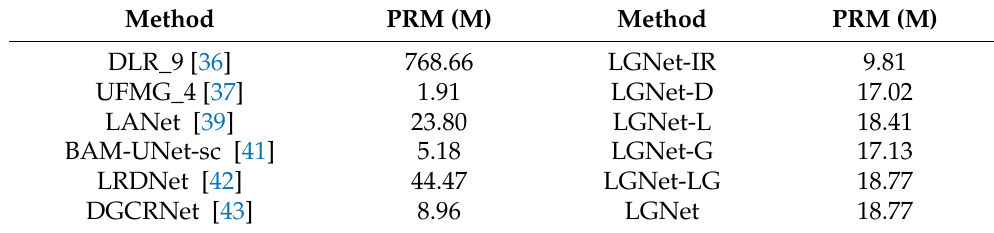
Table 7. Experiments of Parameters